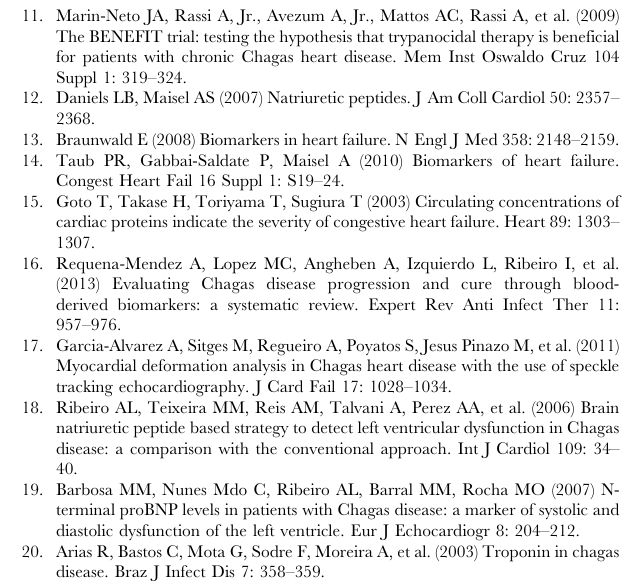
Figure S1 Receiver operating characteristic (ROC) curves for selected biomarkers. The curves compare T-cruzi infected individuals in stage AB versus stage CD. Diagonal reference line indicates an AUC value of 0.5.